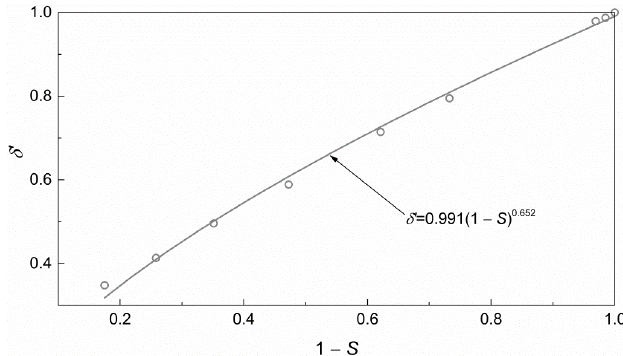
Figure 5. Comparison between calculated mean pore diameter δ ′ and that estimated by δ ′ = α ( 1 − S ) β . Here, δ ′ is normalized by δ 0 which is the mean pore diameter when water saturation is 0.